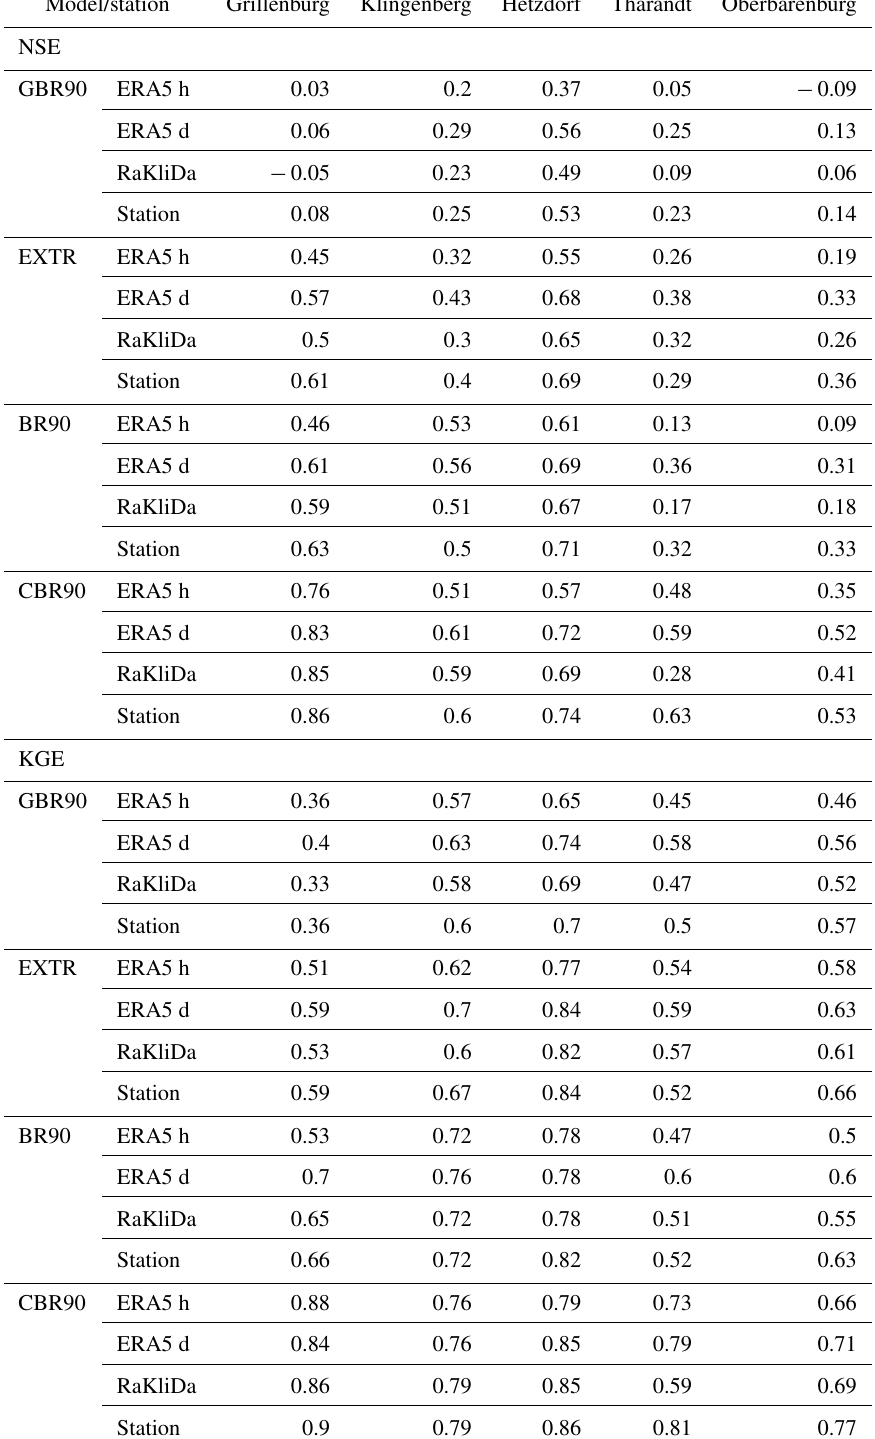
Table E1. Daily evaporation skill scores for the whole